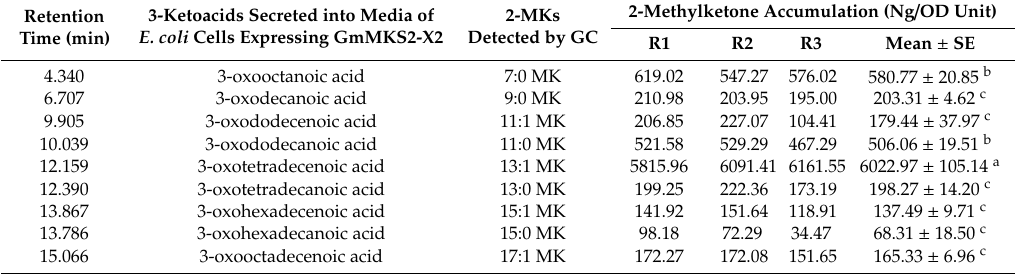
Table 1. Quantification of 2-methylketones detected following heating of the culture media of E. coli cells expressing the main isoform of GmMKS2 (GmMKS2-X2). Cells were grown, and media were collected and treated as described in “Materials and Methods.” The products 2-methylketones, which were derived from 3-ketoacids, were quantified by comparison of the peak areas with those of a linalool internal standard using GC. Values are averages ± SE calculated from three replicates (R1, R2, and R3). Significant di ff erences were assessed by one-way ANOVA followed by Tukey’s HSD (honest significant di ff erence) test. Means with di ff erent letters are significantly di ff erent ( p <